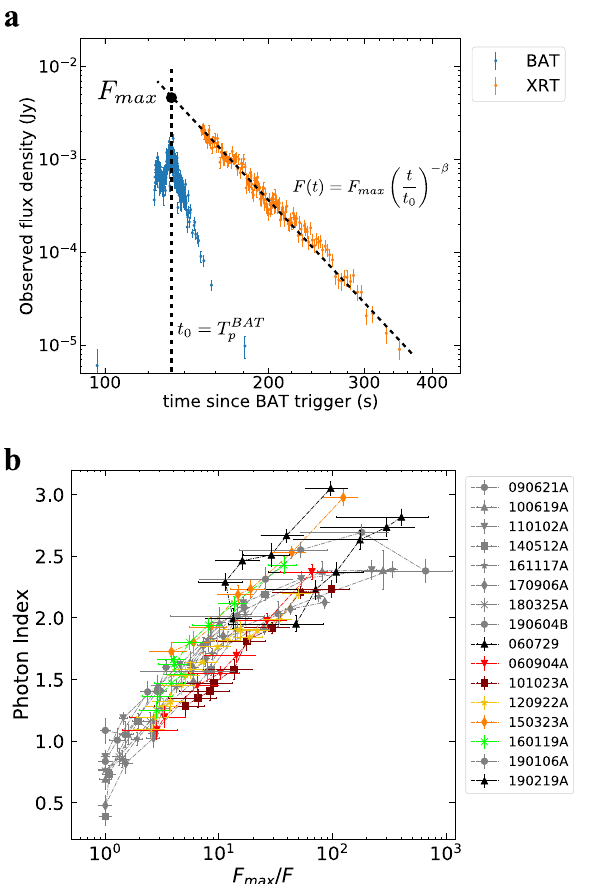
Fig. 6 Spectral evolution expected in case of adiabatic cooling (solid lines) superimposed to the extended sample. In a , the theoretical curves are computed considering adiabatic cooling and inef fi cient synchrotron cooling, taking also into account the effect of HLE. The value of λ speci fi es the evolution of the magnetic fi eld. We adopt a SBPL as spectral shape with α = − 1/3 and β = 2.0, an initial observed peak frequency of 100 keV and a s s thickness of the expanding shell that is constant in time. In b we show the spectral evolution expected in case of combined adiabatic cooling and mild synchrotron cooling. The adopted spectral shape is a SBPL plus an exponential cutoff. The initial peak frequency is 100 keV. The theoretical curves are computed taking also into account the effect of HLE. In both panels, the error bars represent 1 σ uncertainties, calculated via spectral fi tting in XSPEC, and the dot-dashed line is the evolution expected considering only HLE, assuming the same spectral shape and initial observed peak frequency. In the legend, we report the name of each